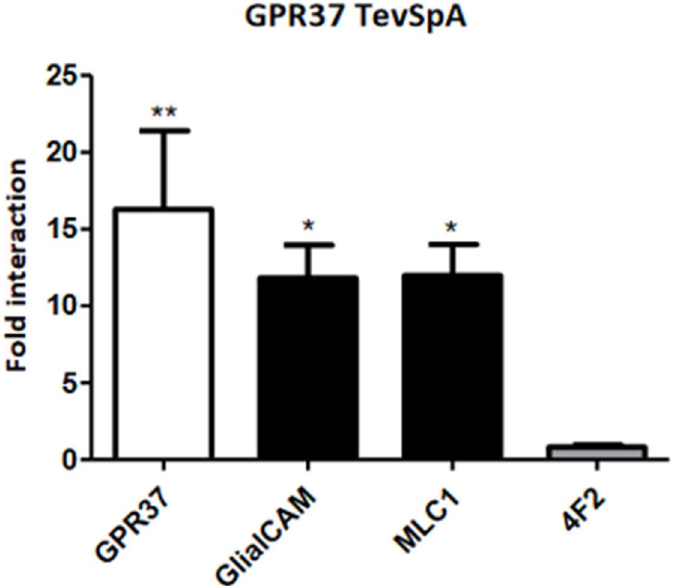
Figure 3. Direct Interaction between GPR37 and GlialCAM/MLC1. Results of split-TEV interaction assays in HeLa cell using GPR37 C-terminally tagged with the N-terminal part of the TEV protease (TevSpA). They were co-transfected with different constructs (GPR37, GlialCAM, MLC1 and 4F2 as a negative control) C-terminally tagged with the C-terminal part of the TEV protease. Plotted data combine the results from three independent experiments. Statistical significance was obtained com- paring the interaction within each group to the interaction with the negative control in Bonferroni’s multiple comparison test (* p < 0.05, ** p < 0.01 in the test versus 4F2). Results show that GPR37 is able to homo-oligomerize and hetero-oligomerize with GlialCAM and MLC1, in the same manner as shown for GPR37L1 by BRET.